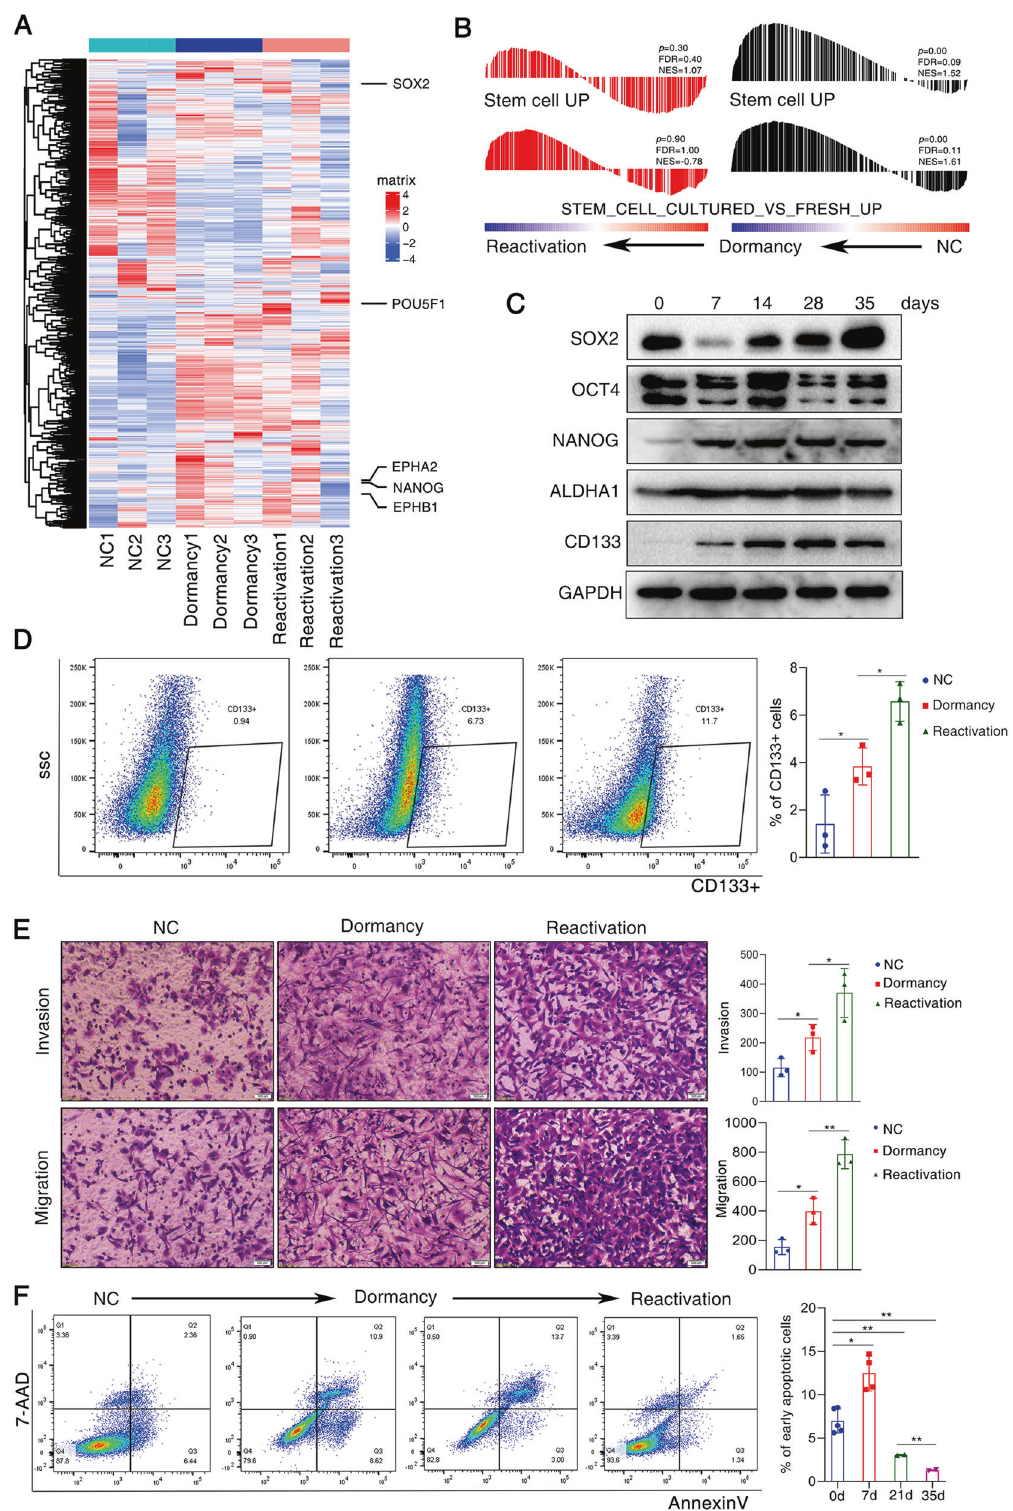
we identi fi ed 108,407 accessible peaks in dormant cells and 107,898 accessible peaks in reactivated cells, which possessed more open chromatin regions than untreated control cells (peak number = 72,309). Peaks were classi fi ed based on the location (UCSC annotation data) and showed the genome